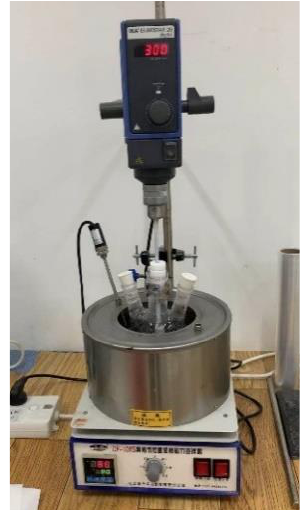
Figure 1. Preparation device for the MMA repair material.